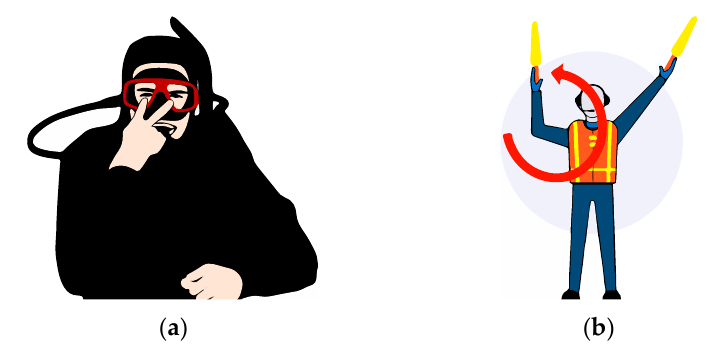
Figure 1. Sign languages for different uses. ( a ) Diving Sign. ( b ) Aviation Sign.